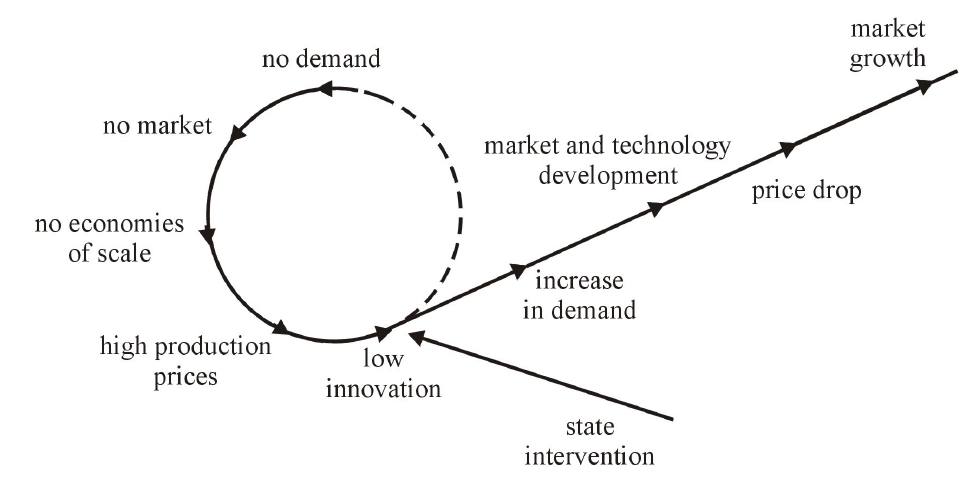
Figure 1. The unreliability of the early photovoltaic market and the e ff ects of state intervention. Source: author’s own